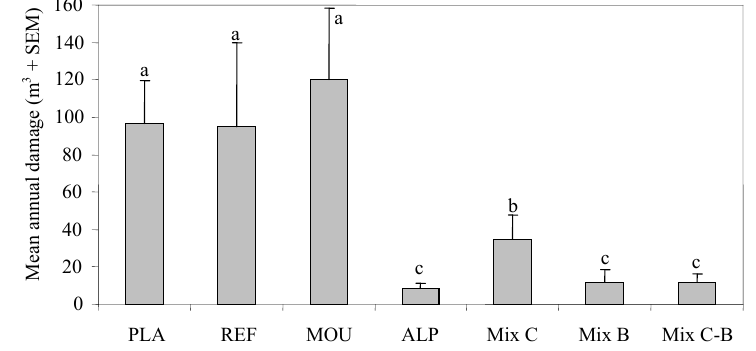
Figure 2. Mean annual damage recorded in different forest types (m 3 every 1000